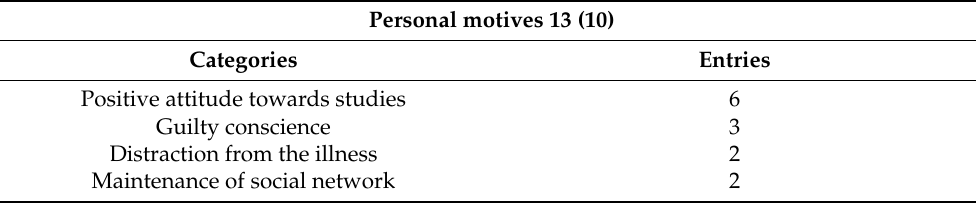
Table 9. Results of the open-ended questions on the reasons for presenteeism (personal